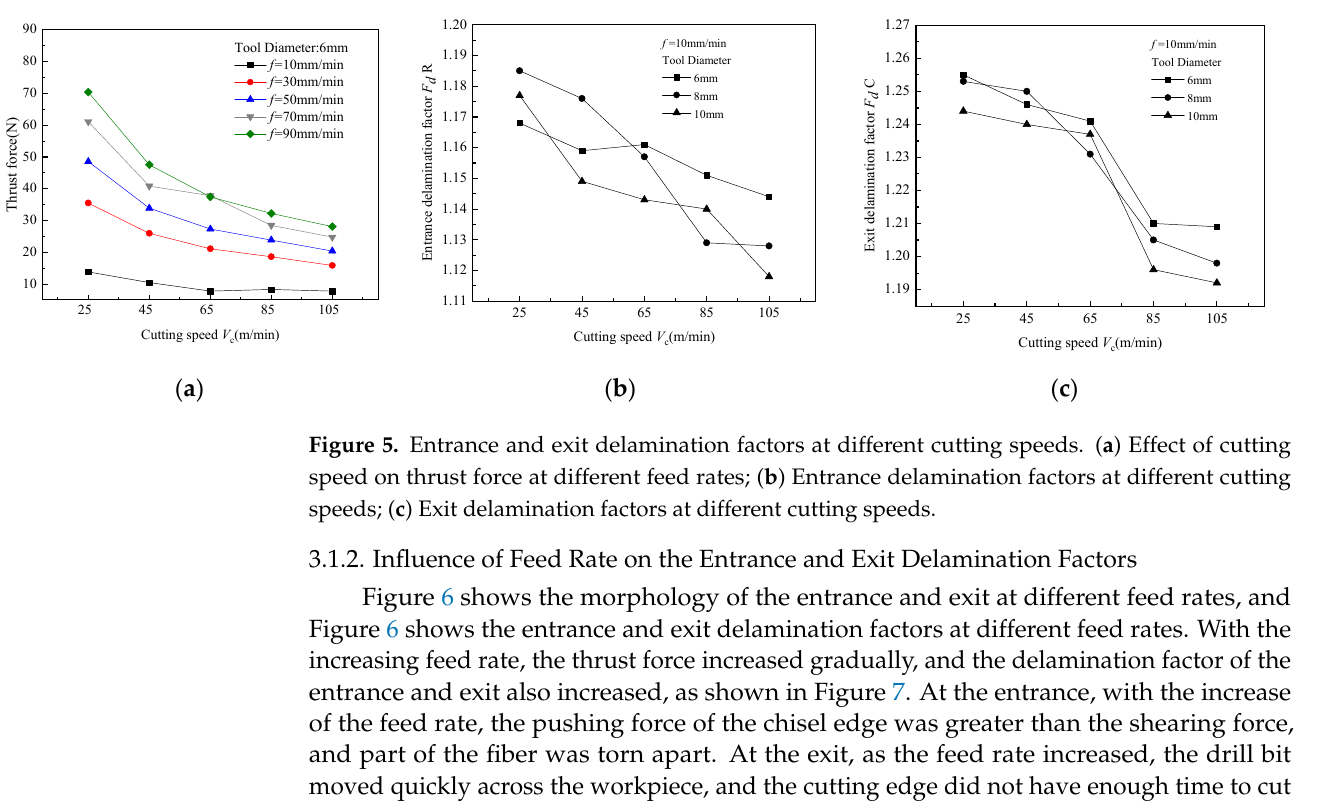
Figure 4. Morphology of entrance and exit at different cutting speeds ( f = 10 mm/min, drill bit di ‐ ameter = 6 mm).